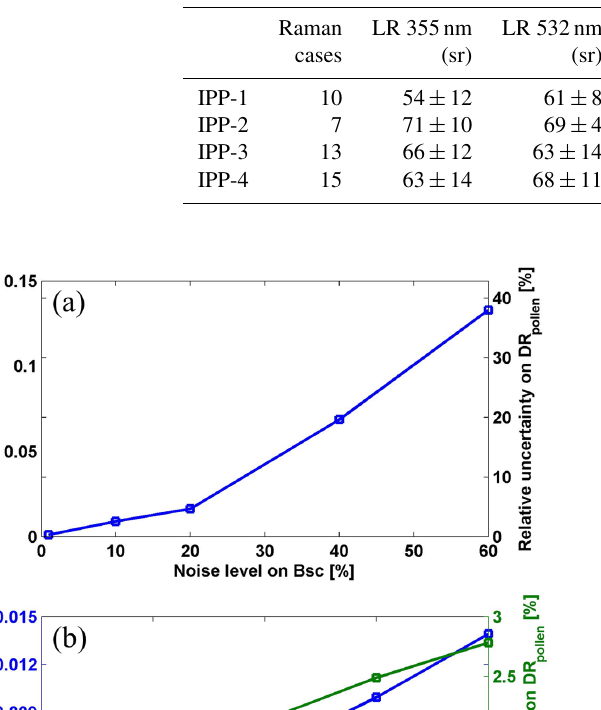
Table 4. Lidar-derived optical values of pollen layer for the intense pollination periods (IPPs) (mean values ± standard derivation are given). LR: lidar ratio, PDR: particle linear depolarization ratio, Å bsc: backscatter-related Ångström exponent.